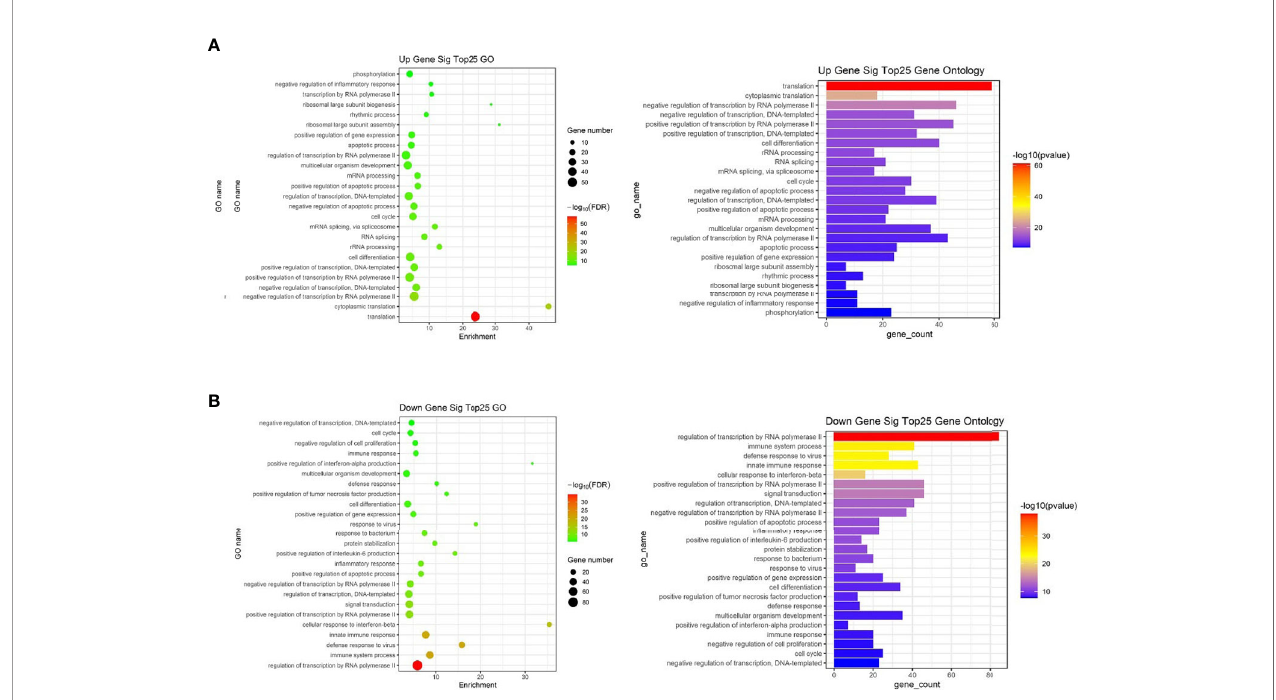
FIGURE 7 | The top 25 signi fi cantly enriched GO terms of the overlapping target genes of differentially expressed miRNAs in spleen lymphocytes of Balb/C mice (Kyn stimulated vs negative control). (A) Up gene Go analysis. (B) Down gene Go